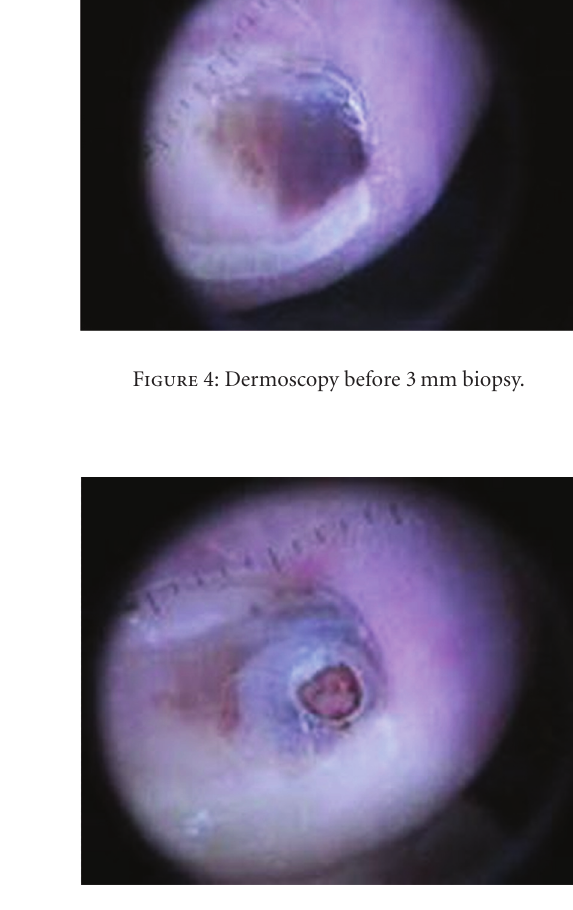
Figure 5: Dermoscopy after 3mm Punch biopsy and H 2 O 2